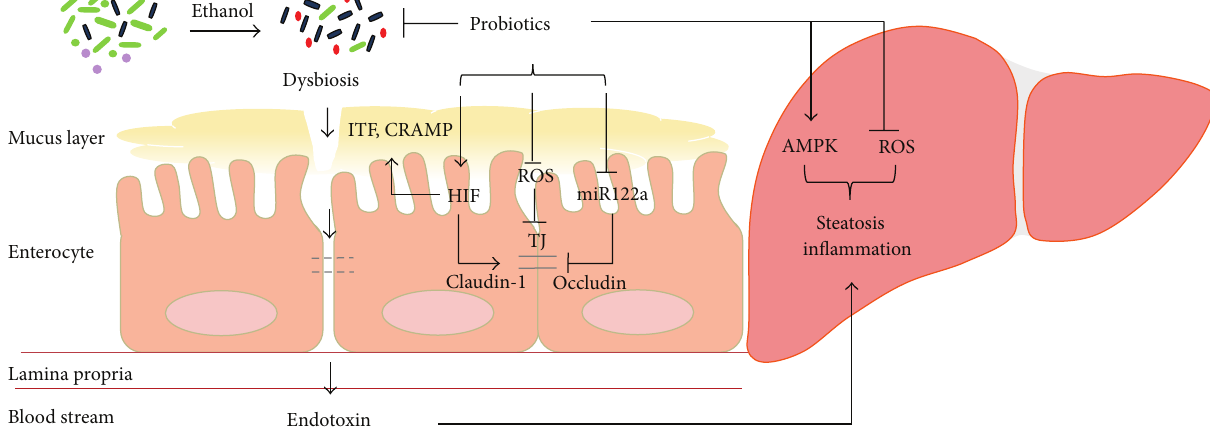
Figure 1: Proposed mechanisms of probiotic function in ALD. Ethanol consumption causes a gut bacterial overgrowth and a dysbiosis leading to impaired mucus layer and dysfunctional tight junctions. The damaged epithelial barrier function results in endotoxemia. Elevated endotoxin activates Kupffer cells in the liver and induces hepatic steatosis and inflammation. Probiotics and related products prevent ethanol- induced effects in the intestine and the liver through multiple mechanisms: (1) positive modification of gut microbiota; (2) reduction of ROS production in intestine and liver; (3) enhancement of mucus layer component, ITF, and antimicrobial peptide, CRAMP, and tight junction protein claudin-1 expression through increased HIF signaling; (4) inhibition of miR122a expression leading to occludin upregulation; and (5) activation of hepatic